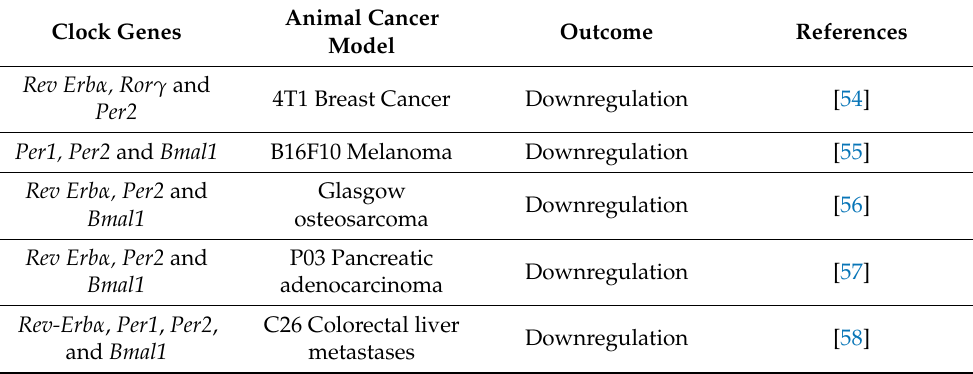
Table 1. Clock gene expression in animal models of different cancer